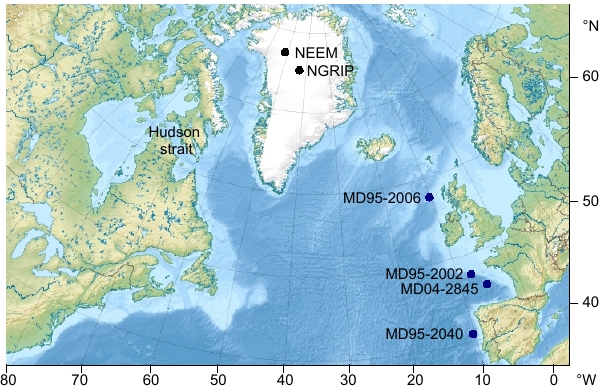
Figure 2. Map of the Northern Hemisphere palaeoclimate archives used in this study. Blue dots: marine cores. Black dots: ice cores. Most of the IRD for H4 and H5 were deposited by icebergs origi- nating from the Laurentide ice sheet and delivered through Hudson Strait (Hemming, 2004). Background map from Uwe